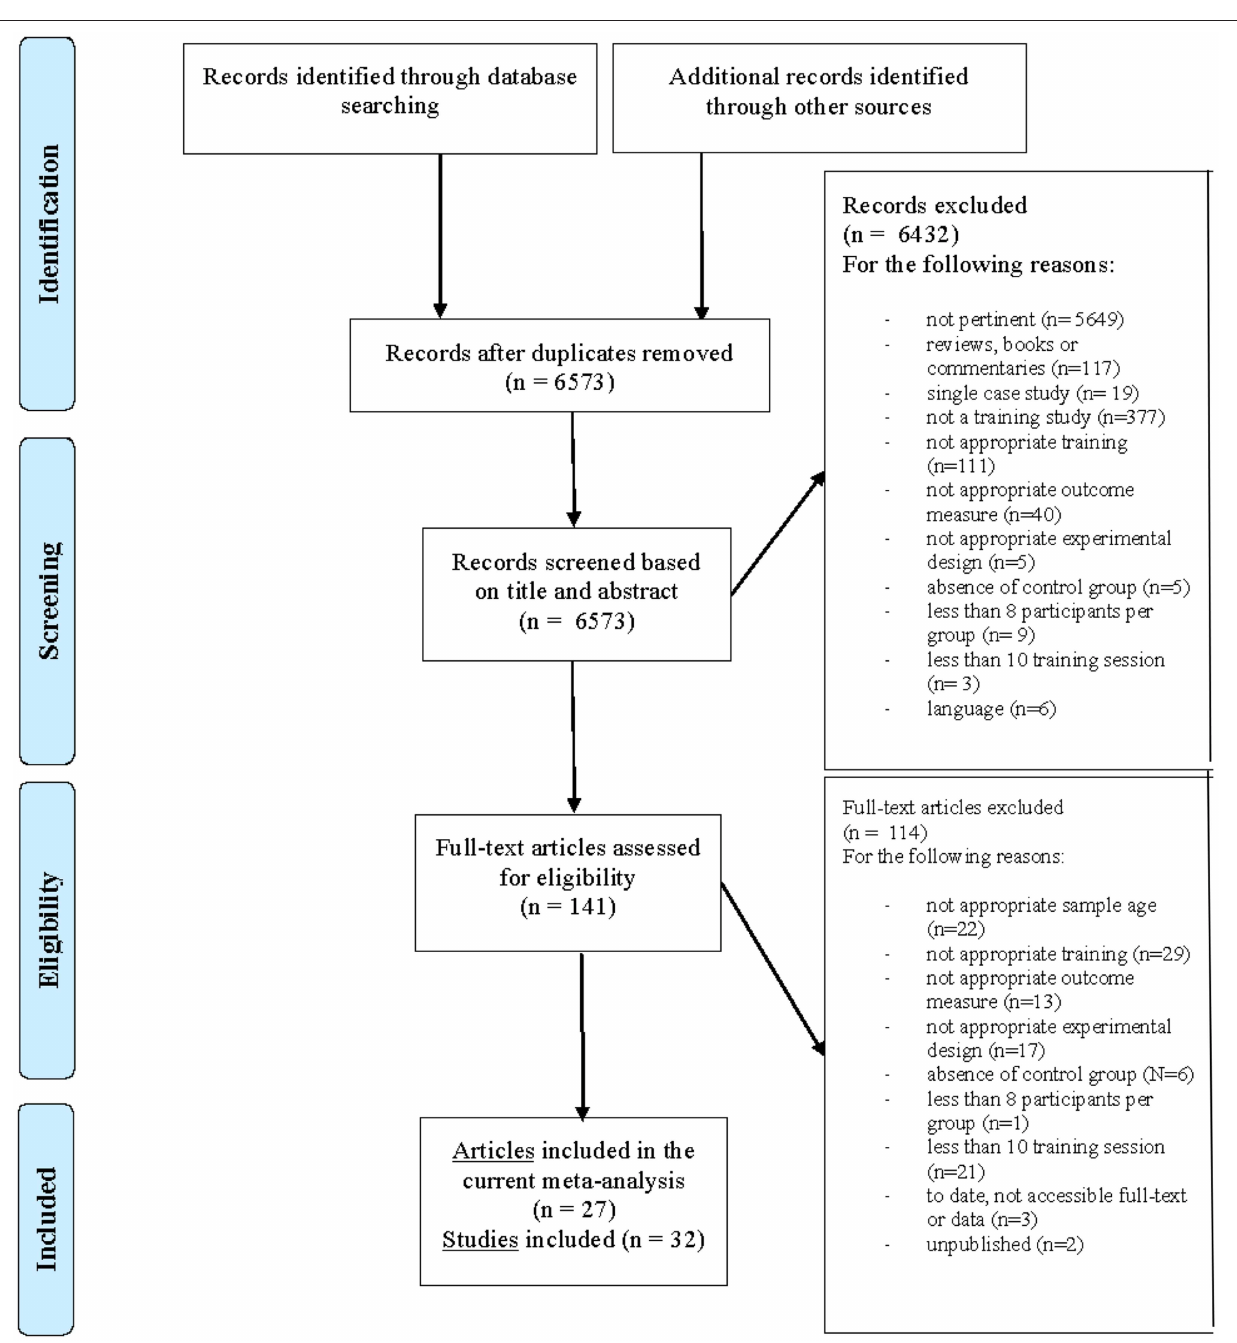
FIGURE 1 | Prisma flow